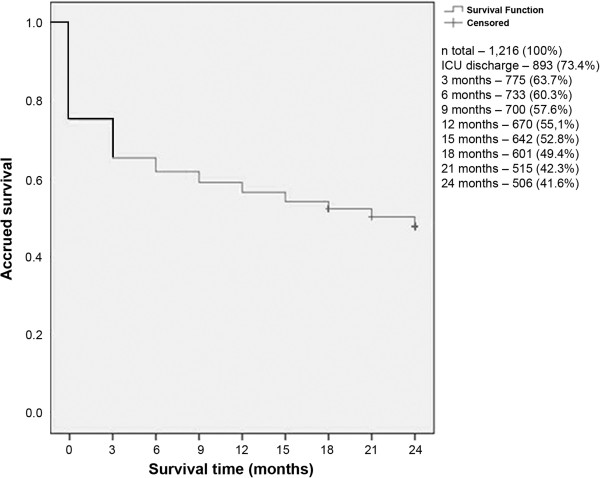
Kaplan-Meier survival curves.